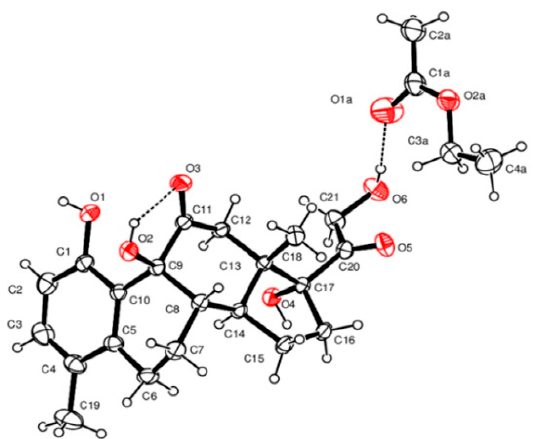
Figure 3. An ORTEP view of compound 6 showing the thermal ellipsoids at a 30% probability level. The crystallographic asymmetric unit is built up by a molecule of compound 6 and a molecule of solvent ethyl acetate. Table 1. Crystallographic data.